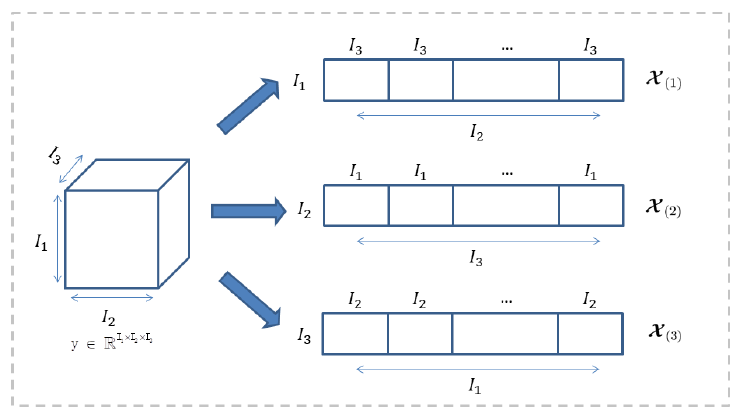
Figure 2. Tensor module